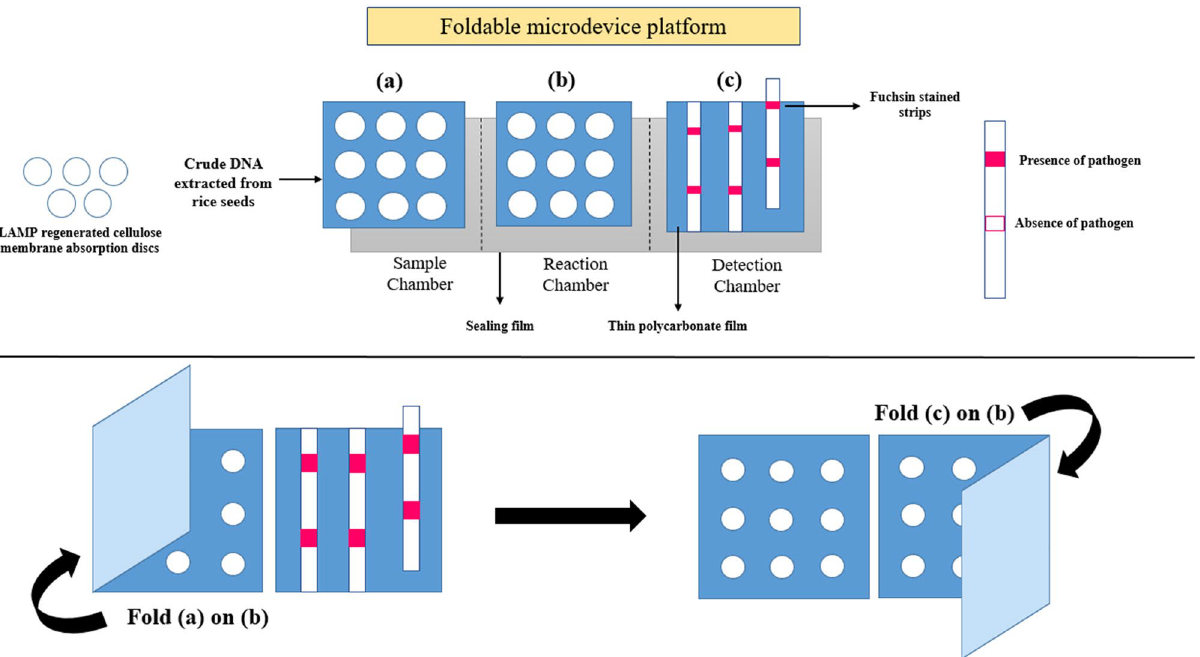
Figure 7. Overview of the membrane-based microdevice design. ( a ) Sample chamber with nine absorption discs, ( b ) reaction chamber, and ( c ) detection chamber with fuchsin stained